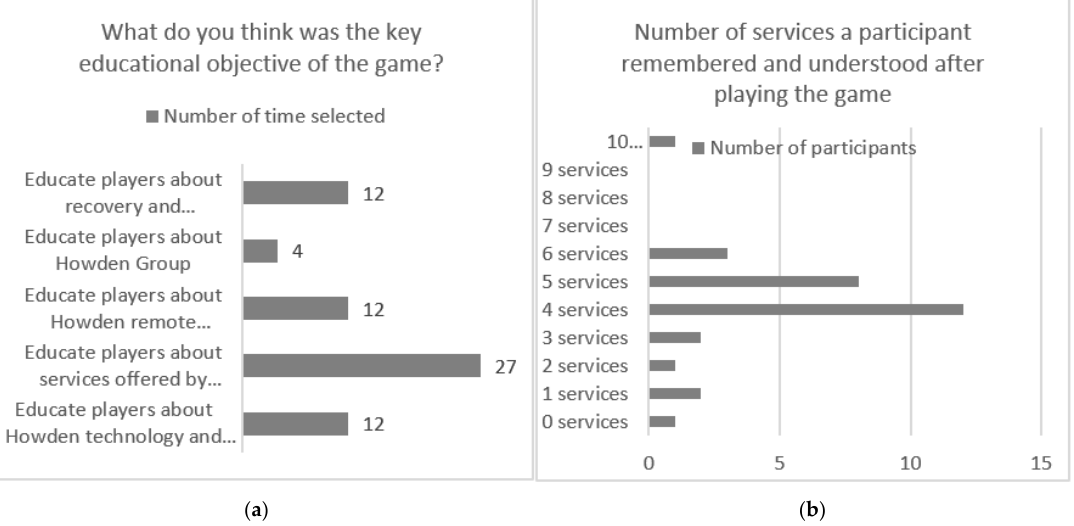
Figure 8. ( a ) Participant response on what they thought were the key educational objective of the game ( b ) a count of the number of services a participant remembered and understood after playing the game.